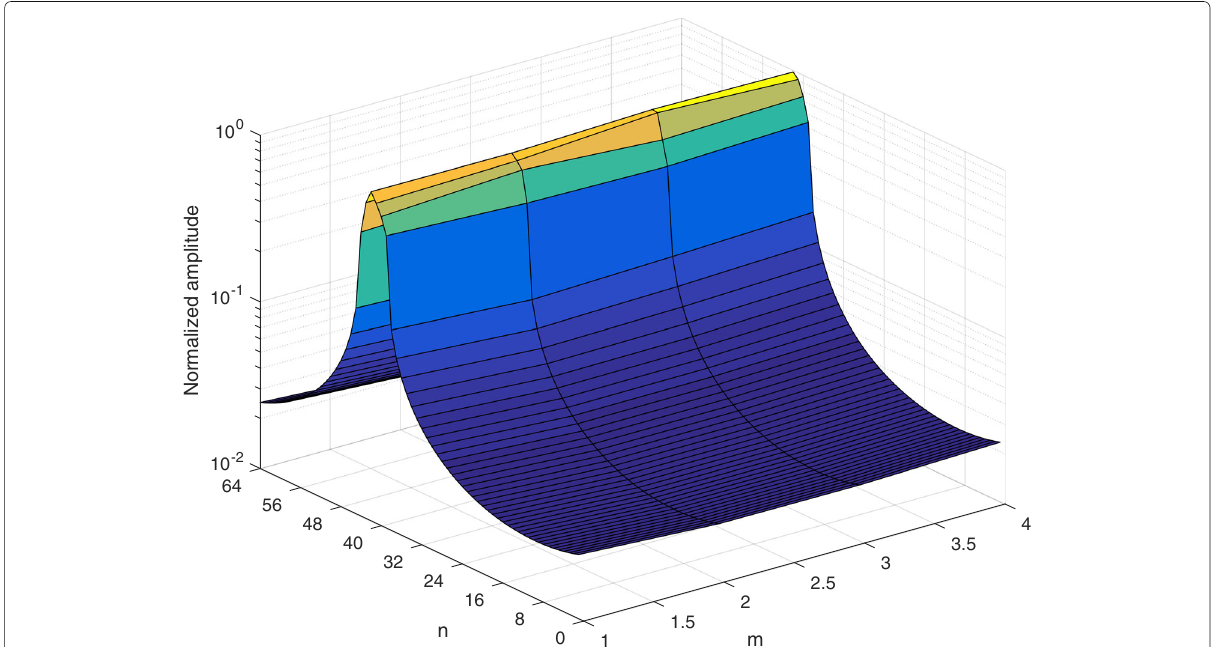
Fig. 1 Normalized amplitudes for the elements of angular-domain channel matrix X k , where N = 64, M = 4, and θ k = 15.5 ◦ . The angular spread for AoD is δ d = 5 ◦ . It is assumed that the waves arriving at the user are usually uniformly distributed in AoA [12]. Therefore, (cid:3) a is equal to